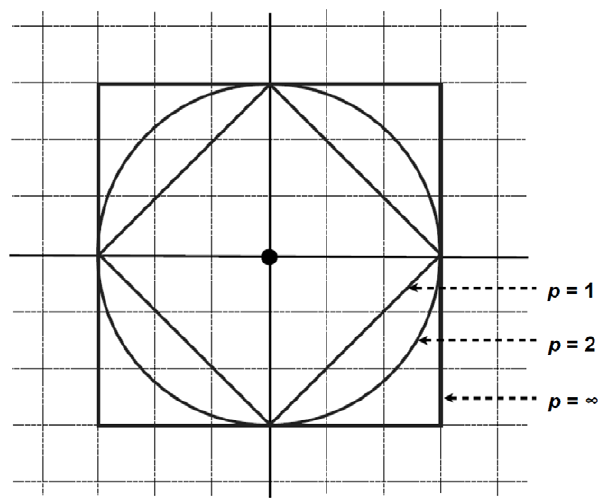
Figure 1. Isosimilarity contour of the origin for different p -values in the Minkowski distance formula (Equation